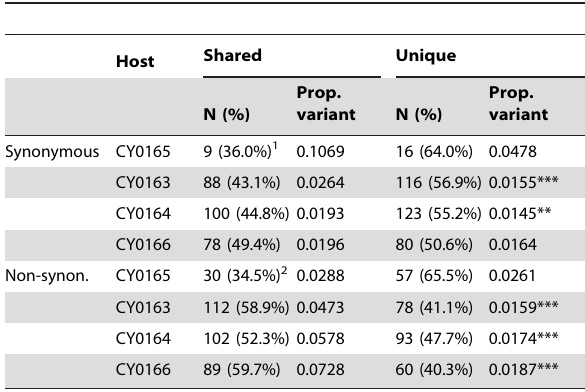
Table 5. Median proportion variant at sites shared or unique to the SIV from each